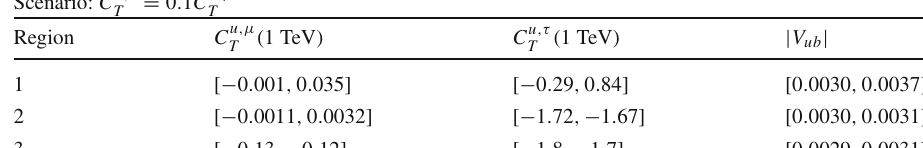
Table 5 Allowed ranges for the tensor short-distance coefficients and | V ub | in the scenario where C u , e